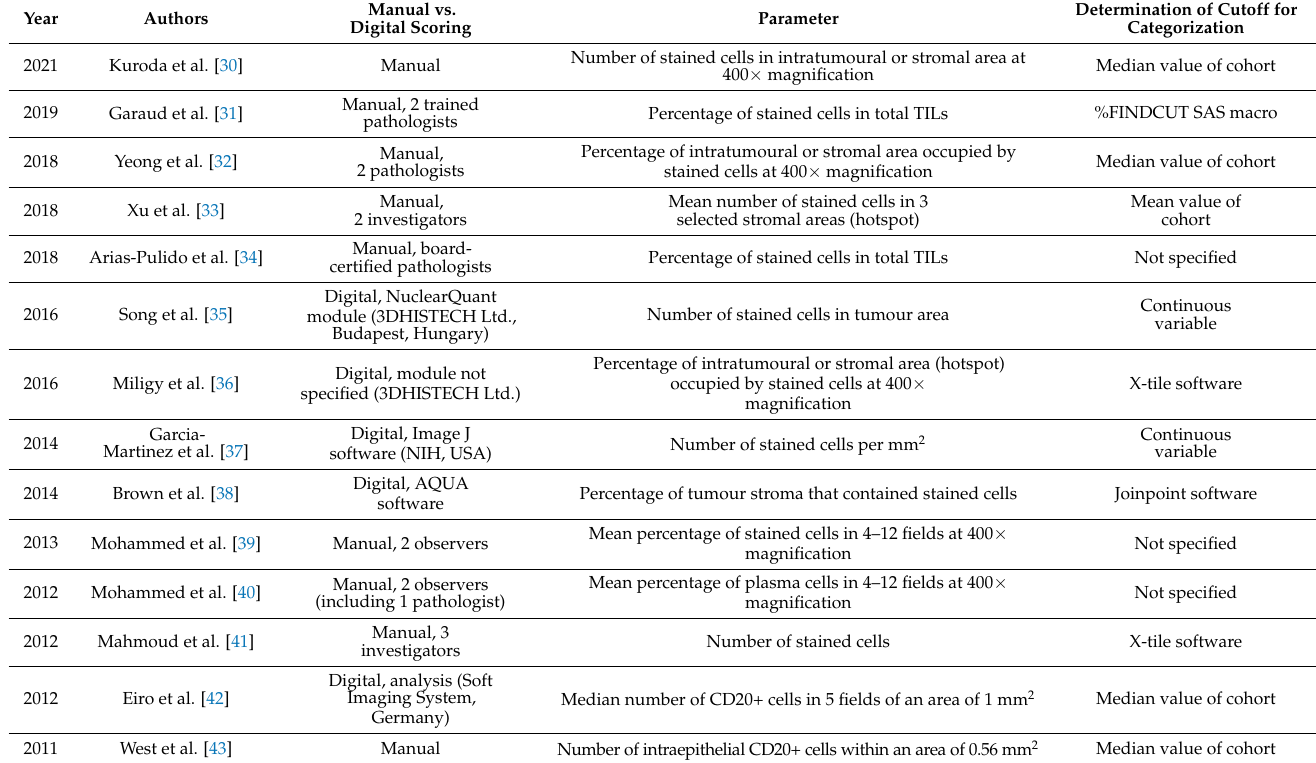
Table 3. TIL-Bs assessment strategy in each